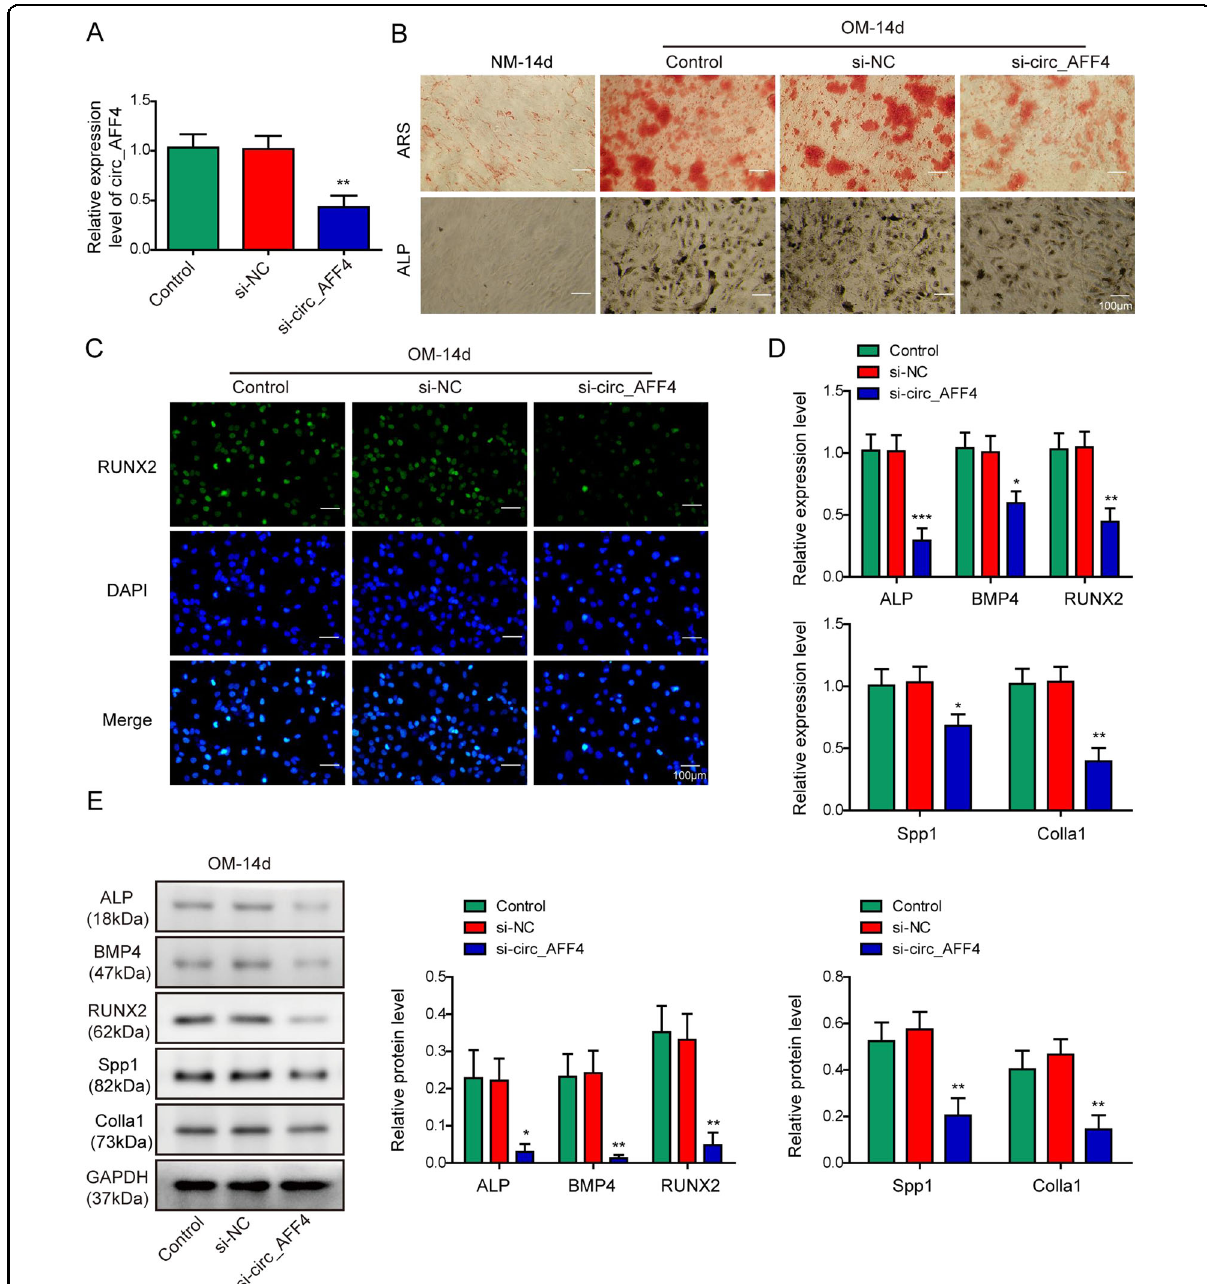
Fig. 2 Silencing of circ_AFF4 attenuated the osteogenic differentiation in BM-MSCs. A BM-MSCs were transfected with si-circ_AFF4 or the negative control. Relative expression of circ_AFF4 was detected by qRT-PCR. B BM-MSCs transfected with si-circ_AFF4 or the negative control were further cultured in OM or NM for 14 days. Osteogenic differentiation was evaluated by performing ARS and ALP staining assays. C RUNX2 expression was determined by immuno fl uorescence staining utilizing RUNX2-speci fi c antibodies. D Fourteen days after the osteogenic differentiation induction, qRT-PCR was performed to measure the mRNA expression of osteogenic marker genes ALP, BMP4, RUNX2, Spp1, and Colla1 in BM-MSCs. E Protein expression of ALP, BMP4, RUNX2, Spp1, and Colla1 was determined by western blot analysis. The data were shown as mean ± SD based on at least three independent experiments. * P < 0.05, ** P < 0.01, and *** P <